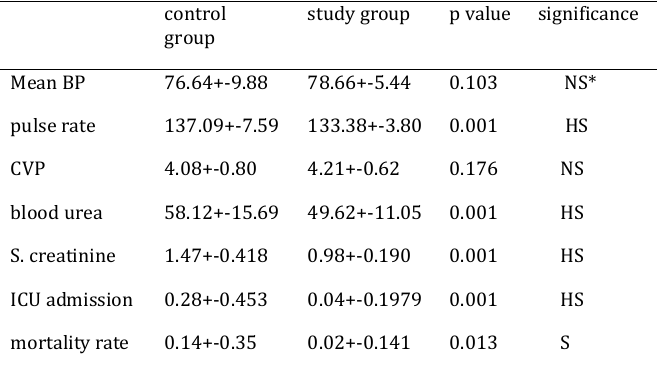
Table (3): Mean, standard deviation, p value and significance of mean BP, PR, CVP, blood urea, s. creatinine, ICU admission and mortality rate. control